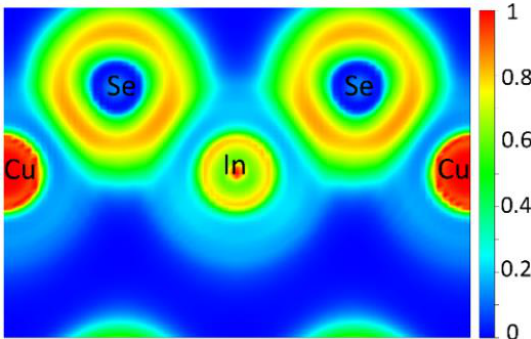
Figure 2. ELF calculated along the (110) plane.